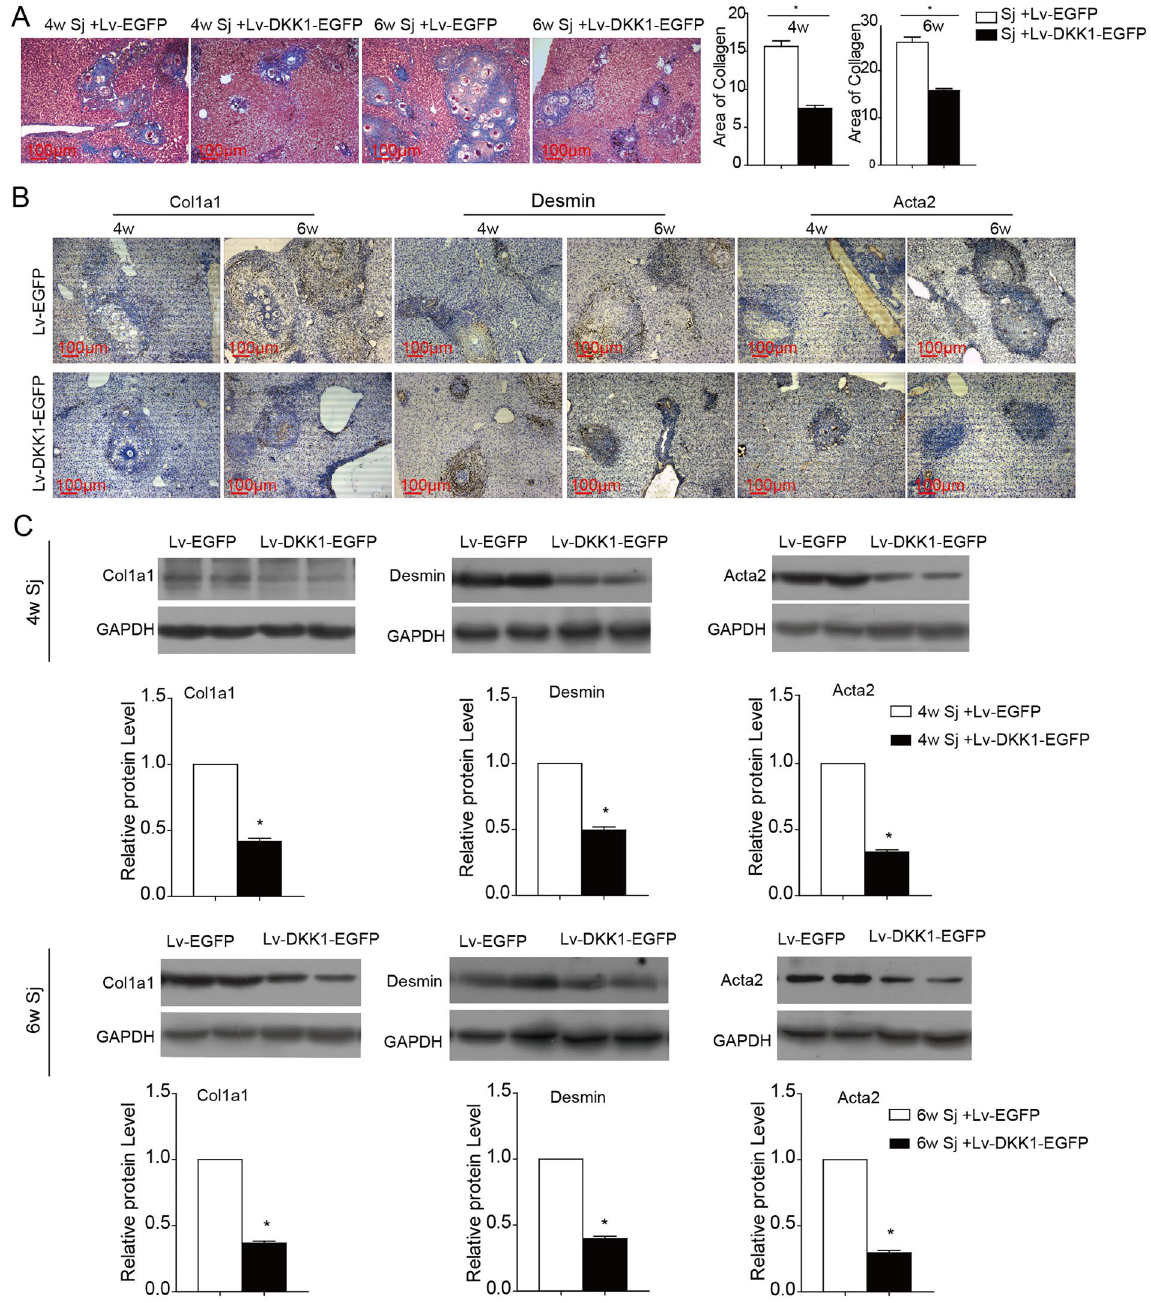
Figure 4. DKK1 transduction protects against schistosomiasis-induced liver fibrosis. Lv-DKK1-EGFP was injected via the tail vein to suppress Wnt signalling in the liver after S. japonicum infection for 4 or 6 weeks. ( A ) Masson’s trichrome staining was used to measure collagen fibre deposition, and the ratio of the collagen-stained area to the total area was also quantified. ( B , C ) Fibrotic markers (Col1a1, desmin, and α -SMA/Acta2) in the liver were assessed by immunohistochemical staining and western blotting. Sj, S. japonicum . Scale bar, 100 μ m. Data represent the mean ± SEM; n = 5 ( * P < DKK1 transduction inhibits the expression of CTGF and TGF- β . To investigate the effects of Wnt sig- nalling on the expression of CTGF and TGF- β , the mice infected with S. japonicum for 6 weeks were transfected with either Lv-DKK1-EGFP or the control vector Lv-EGFP in vivo by tail vein injection. Two weeks later, the liver tissues and hepatocytes were isolated to examine the expression of CTGF and TGF- β . The results showed that DKK1 reduced the mRNA levels of CTGF, TGF- β and the Wnt target gene Sox9 in liver tissues and hepatocytes (Fig. 5A,B), and the protein levels of CTGF, TGF- β (Fig. 5C,D and Supplementary Fig. 13) and β -catenin (Fig. 5C) were also decreased in the hepatocytes.